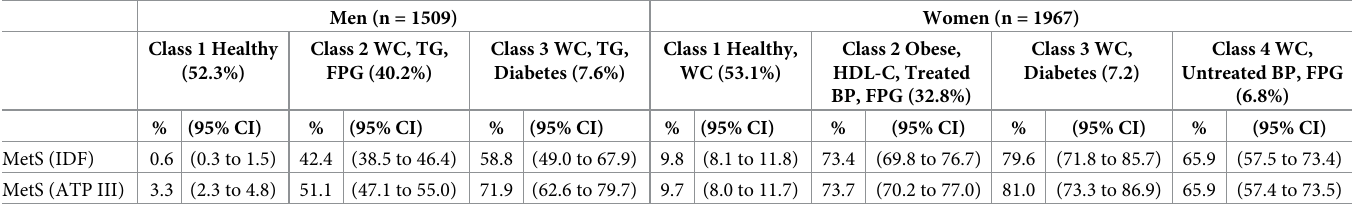
Table 3. Overlap between latent cardiometabolic classes and metabolic syndrome.